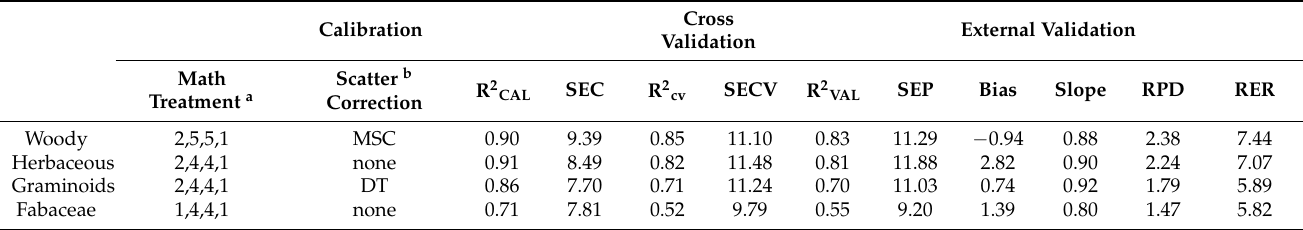
Table 2. Calibration and validation statistics of prediction models used to determine the diet composition (% presence) in Pyrenean chamois fecal samples by near infrared reflectance spectroscopy analysis. Cross Calibration External Validation